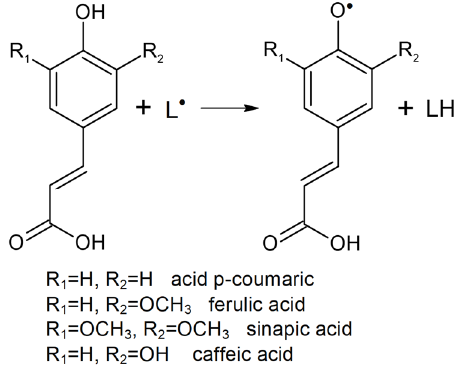
Figure 2. The mechanism of free radical scavenge by HCs.